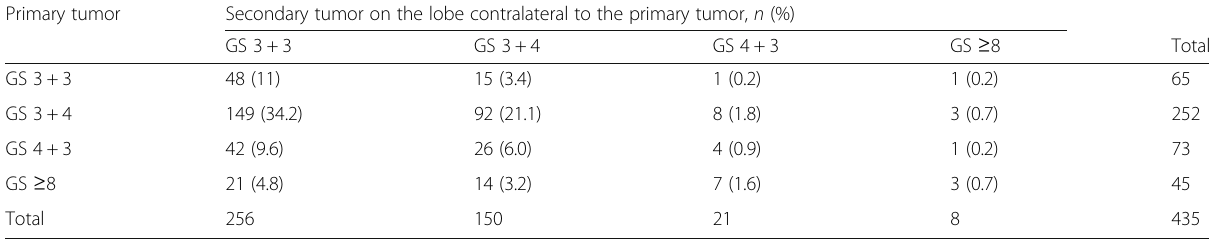
Table 3 Cross-tabulation of histology (Gleason score) of primary and secondary tumors on the contralateral lobe to the primary tumor among patients with bilateral multifocal tumors ( n = 435) Primary tumor Secondary tumor on the lobe contralateral to the primary tumor, n